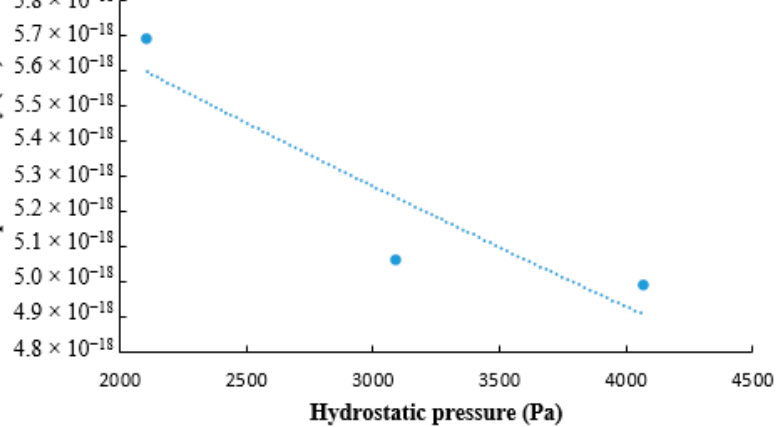
Figure 7. Curve of average permeability of BMSF/PCL scaffold versus hydrostatic pressure.